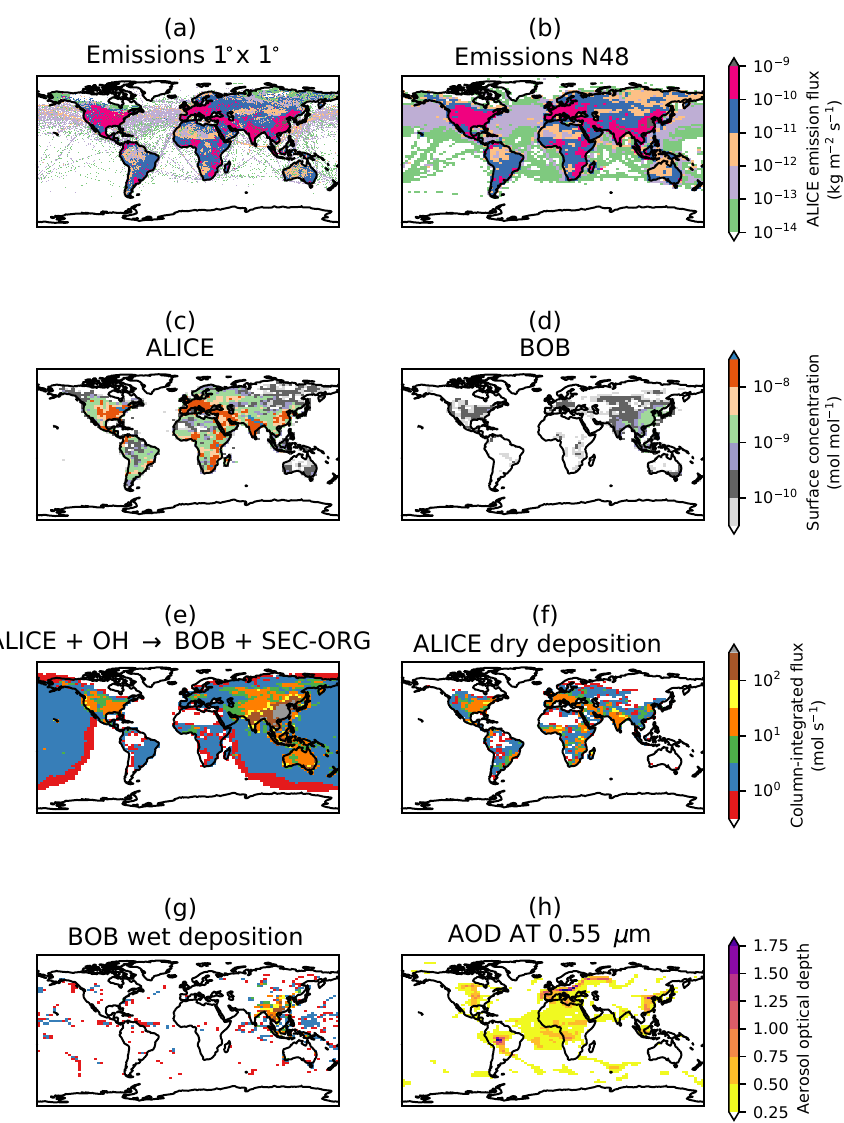
Figure 4. Showing output from the various UKCA tutorial tasks. (a) 1 ◦ × 1 ◦ supplied September emissions. (b) Emissions re-gridded to N48. (c) 3h mean ALICE surface mole fraction after the tutorials have been completed. (d) as for (c) , but for BOB. (e) 3h mean column- integrated flux through Reaction (R1). (f) 3h mean column-integrated ALICE dry deposition flux. (g) 3h mean column-integrated BOB dry deposition flux. (h) 3h mean total aerosol optical depth from GLOMAP-mode at 0.55µm. ALICE and BOB were both initialised